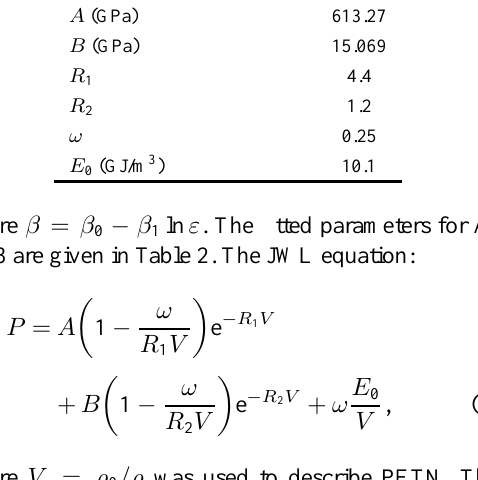
Table 3. When compared with Shot SV-3, the predicted deformation was approximately 25% smaller than that shown in Fig.